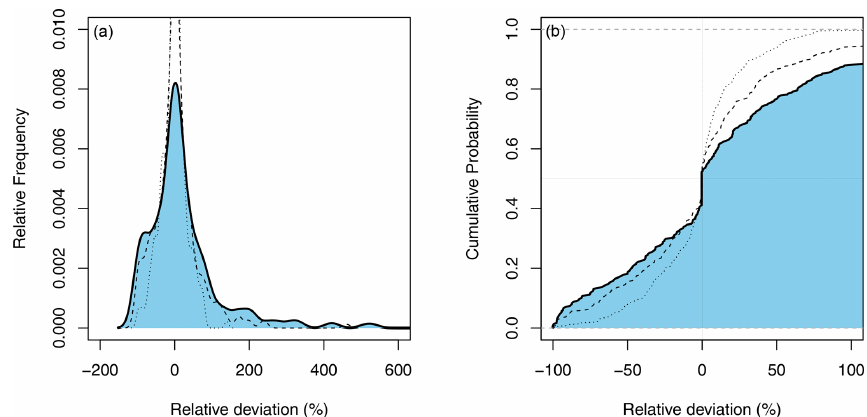
Figure 4. Uncertainty of the annual probability estimator as compared to the mixed probability estimator. Shown are the empirical probability density (a) and the cumulative probability (b) . Full line with shaded blue area refers to the 100-year event. For comparison the 50-year event (dashed line) and the 20-year event (dotted line) are shown.